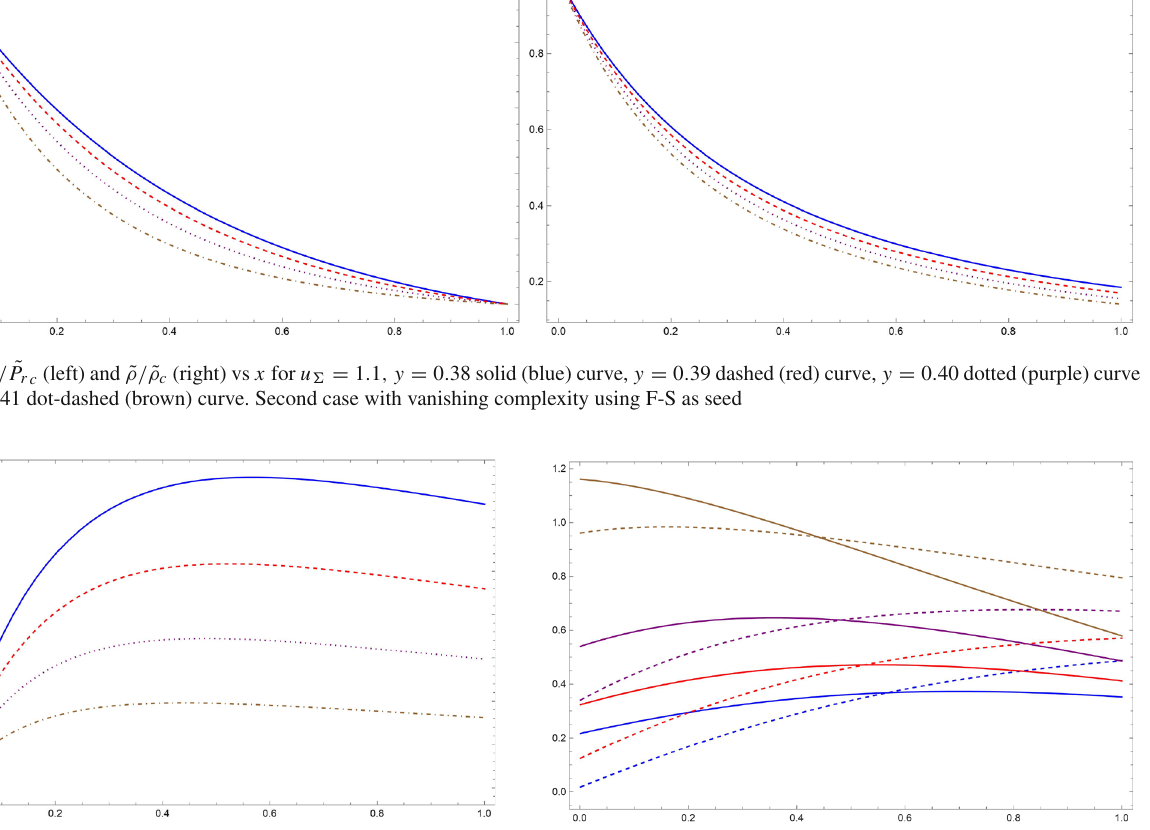
Fig. 4 ˜ (cid:8)/ ˜ P rc vs x for u (cid:5) = 1 . 1 , y = 0 . 38 solid (blue) curve, y = 0 . 39 dashed (red) curve, y = 0 . 40 dotted (purple) curve and y = 0 . 41 dot-dashed (brown) curve. Second case with vanishing complexity using F-S as seed